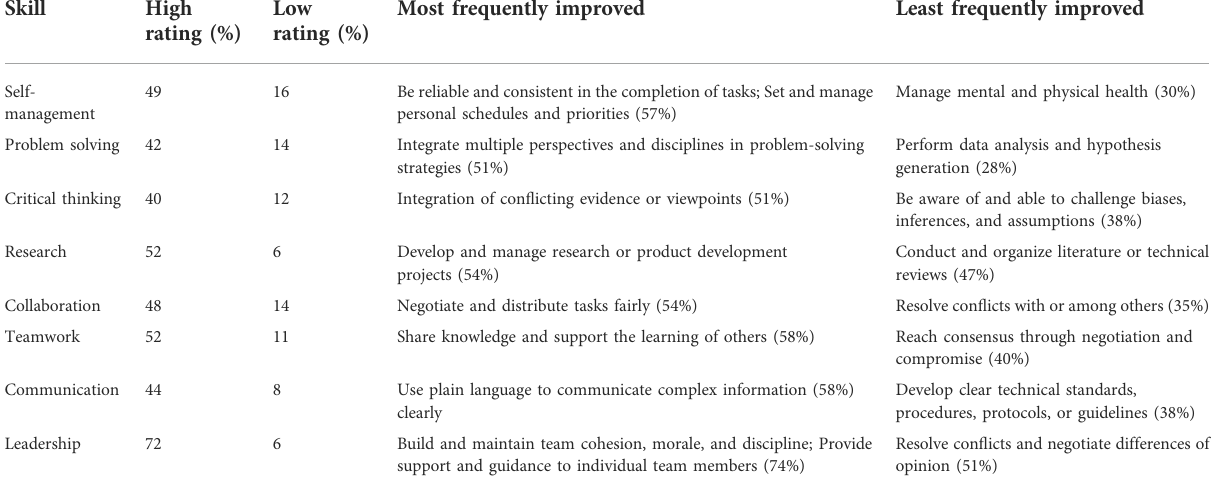
TABLE 4 High-order skills development. The percentage of respondents rating their improvement as high (signi fi cant or profound) or low (none or minor). The most (least) frequently improved abilities are the abilities that most (least) respondents identi fi ed as signi fi cantly or profoundly